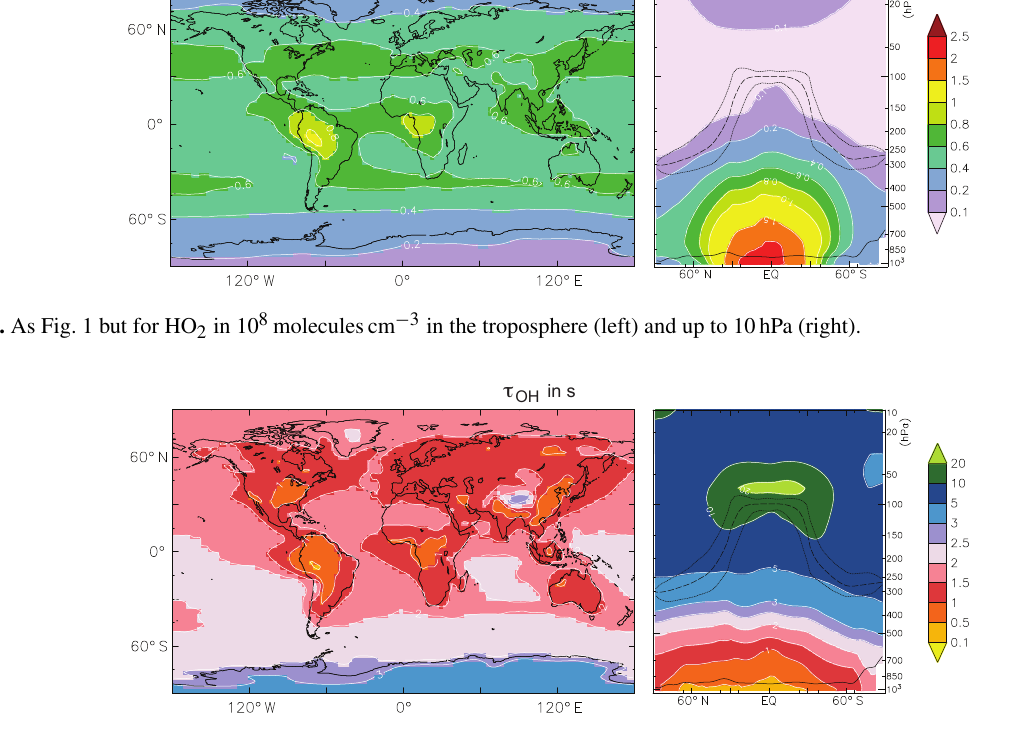
Figure 4. As Fig. 1 but for the OH lifetime ( τ OH , seconds) in the troposphere (left) and up to 10hPa